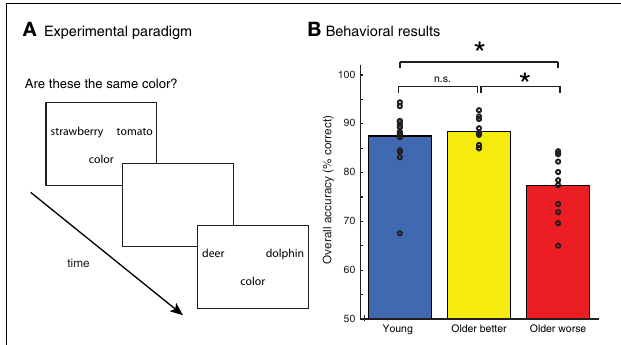
FIGURE 1 | (A) Experimental paradigm. Pairs of words were presented and participants were asked whether they matched on an object attribute (color or shape). (B) Accuracy of judgments on all tasks for young adults and two groups of older adults, divided into better and poorer performers based on median-split performance. Individual subject scores are shown as unfilled circles. ∗ indicates a difference between groups at p < 0 .